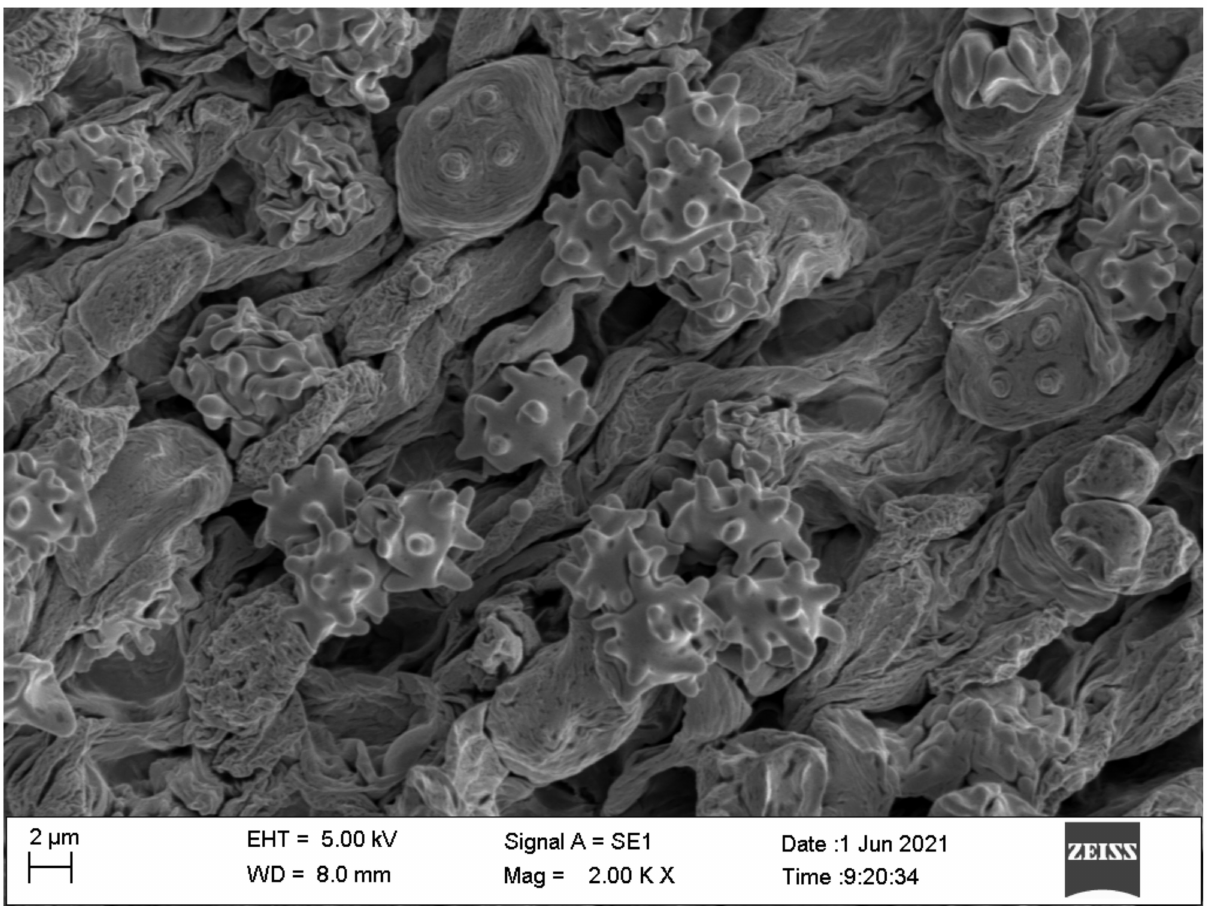
Figure 7. Basidiospores under SEM, from Asproinocybe sinensis HMJAU59025